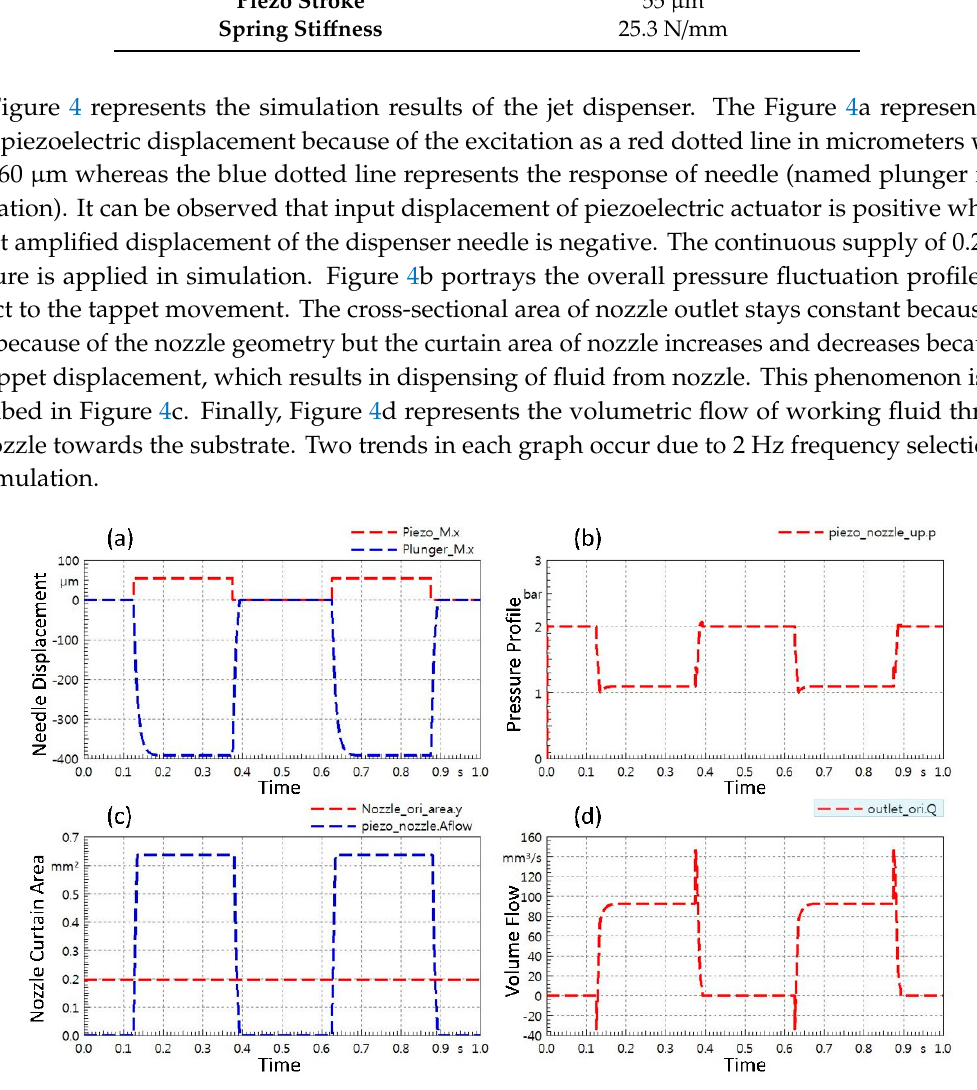
Figure 3. Geometry based modelling of the jet dispenser with a detailed simulation model representation of jet dispenser on SimulationX. Table 2. Parameters and their values used in the simulation.